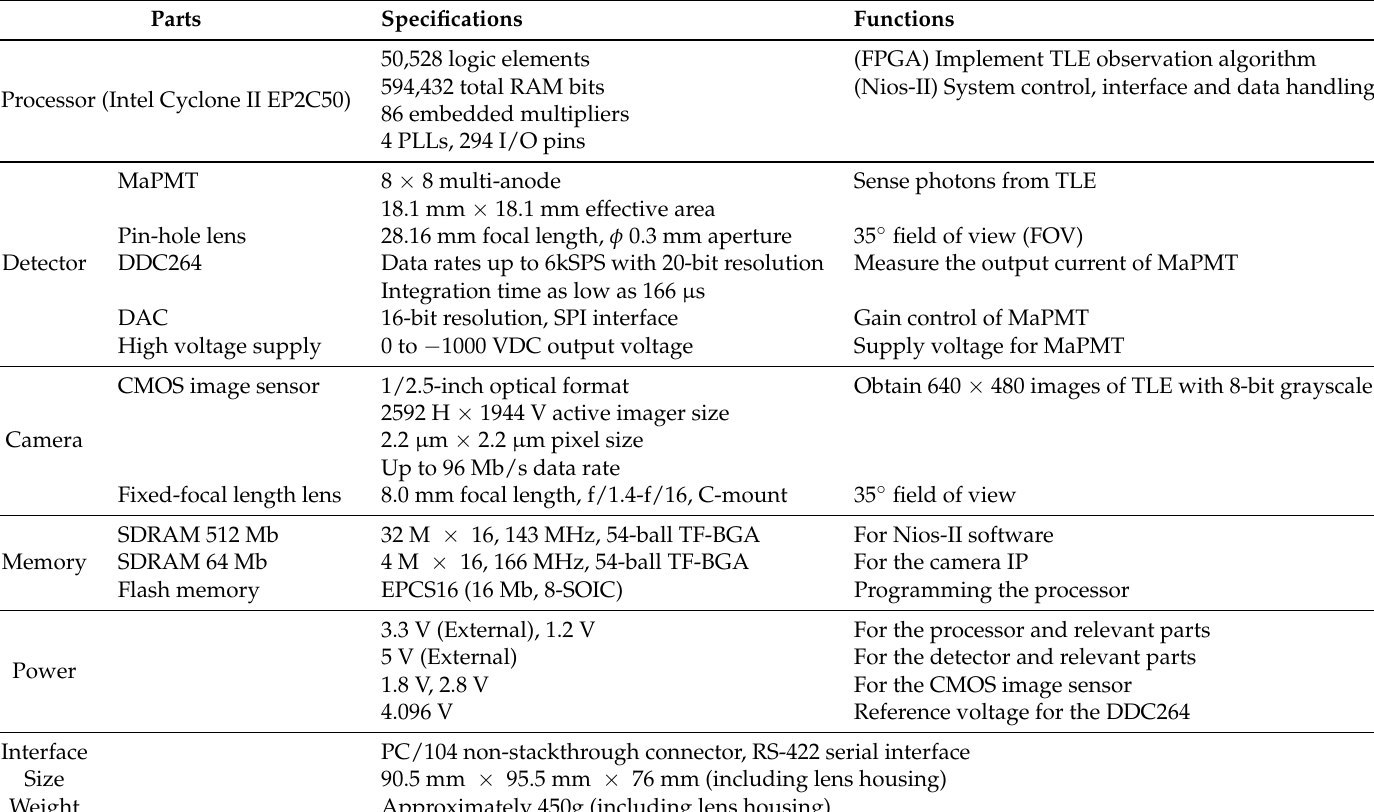
Table 2. Hardware Specification Summary of the TLE Observation